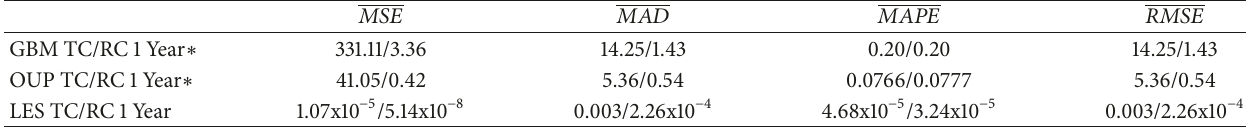
Table 15: TC/RC best error measures for 2013 forecasts after 1000 MC simulations.